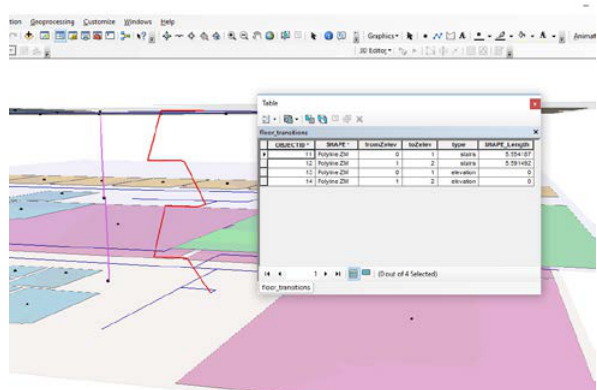
Figure 6. Capturing stairs and elevator in ArcScene